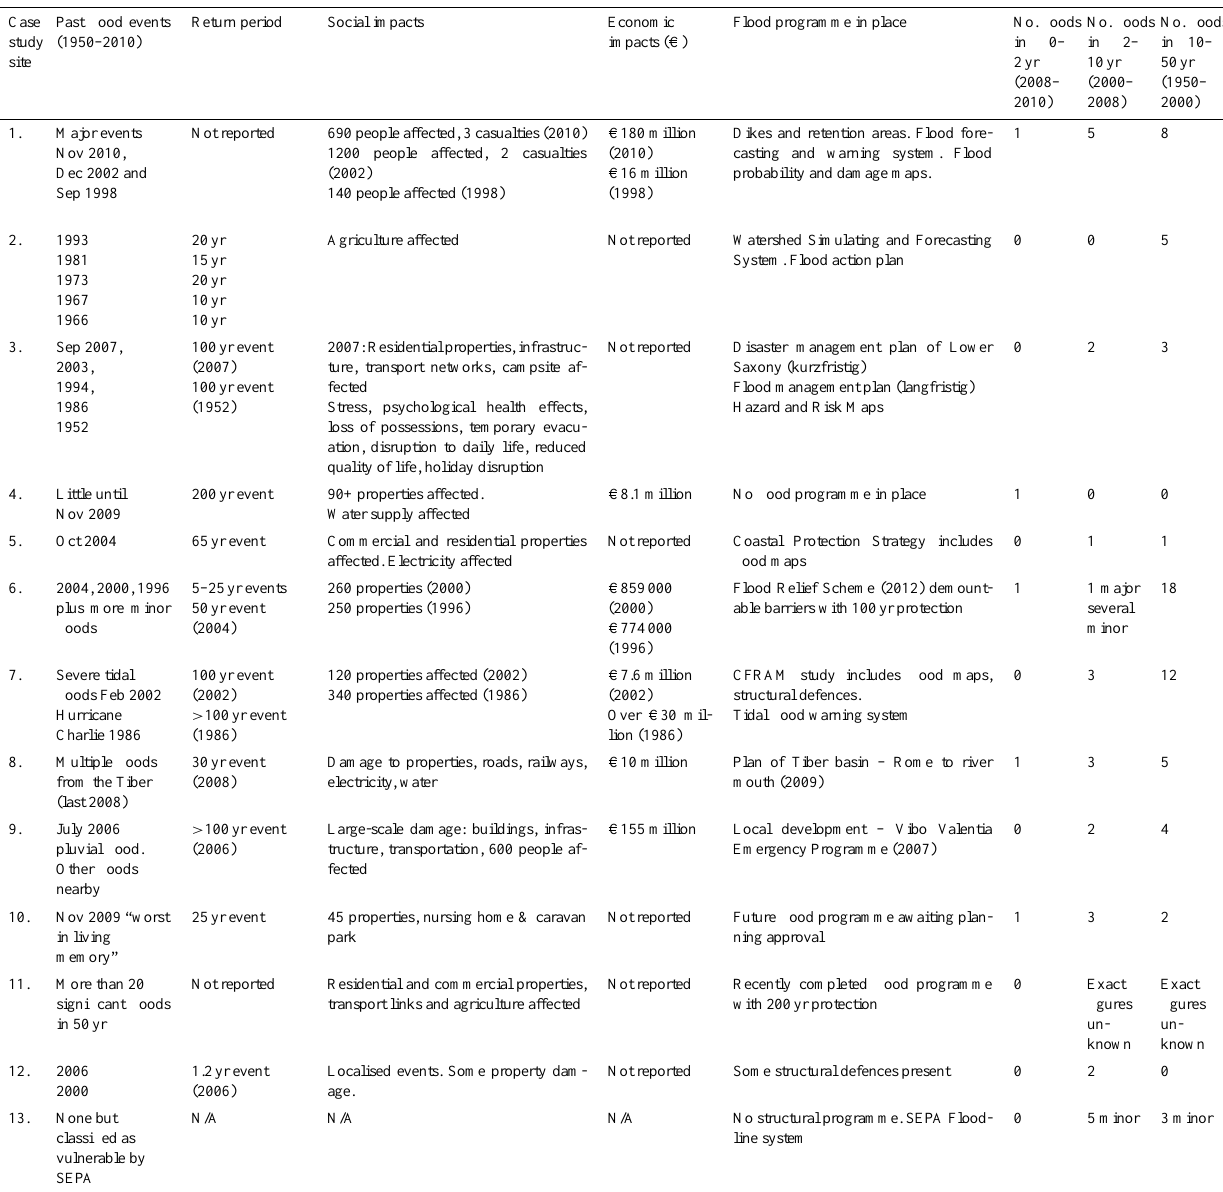
Table 2. Characteristics of previous flood events by case study